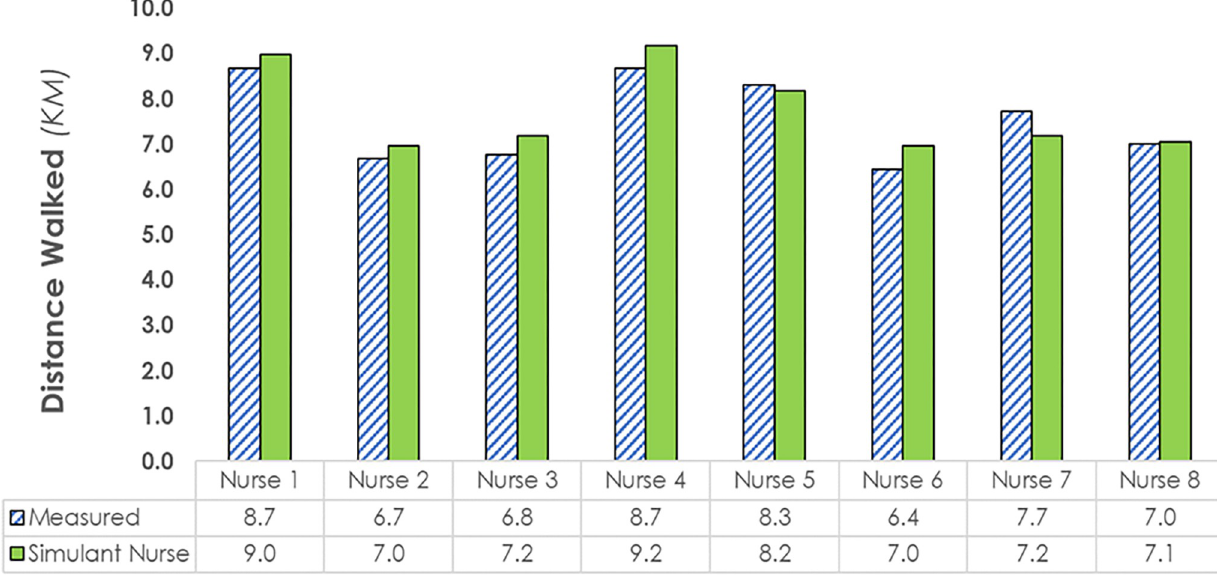
Fig 3. Distances walked by the simulant-nurse and the actual nurse (measured via step counter) during a 12-hour shift.